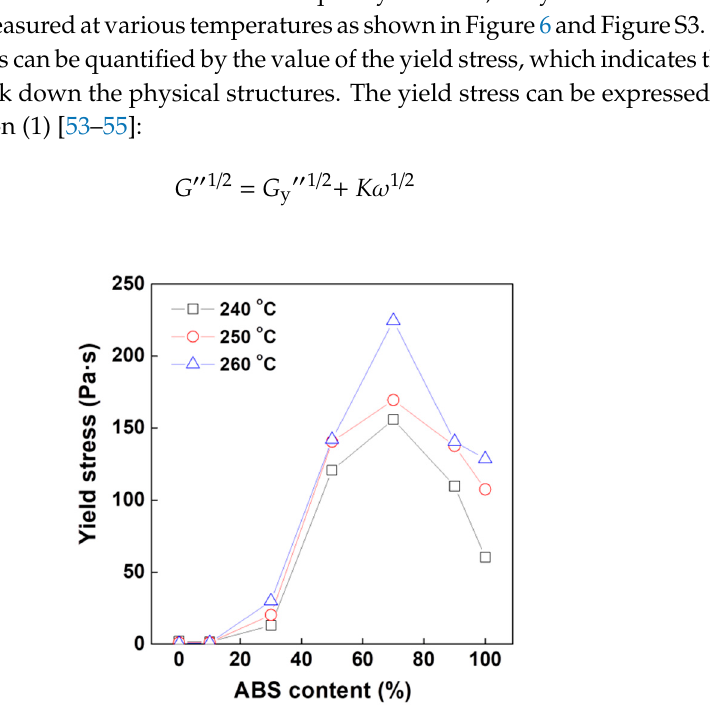
Figure 6. Yield stress (G y ″ ) of PC/ABS blend with increasing ABS content at given measuring